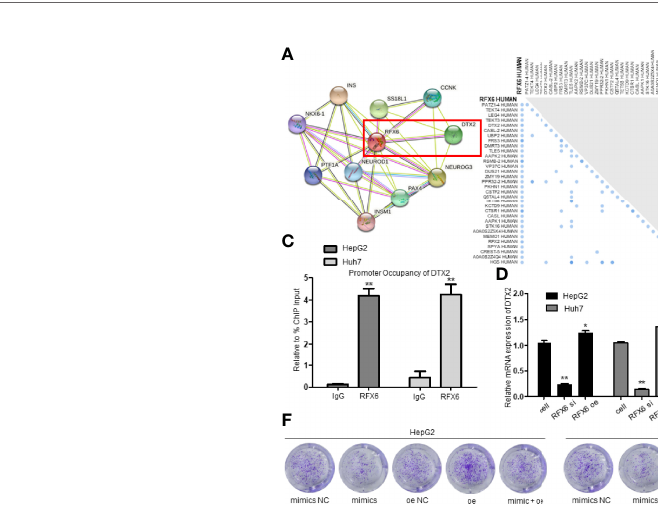
FIGURE 7 | Expression of RFX6 promotes the translation of DTX2 and participates in the Notch pathway. (A) STRING analysis predicted a network of proteins that interacted with RFX6 (left panel). UniProt analysis of probable interacting proteins of RFX6 (right panel). (B) STRING analysis of possible interacting proteins of DTX2. (C) Promoter occupancy of the DTX2 gene by RFX6 performed by ChIP-qPCR. Data were represented as mean ± standard deviation (SD), n = 3, ** p < 0.01. (D) Expression of RFX6 increased the mRNA expression of DTX2. Data were represented as mean ± standard deviation (SD), n = 3, * p < 0.05, ** p < 0.01. (E) Notch1 was con fi rmed to interact with DTX2 in HepG2 cells by co-IP assay. (F) Proliferation of liver cancer cells was retrained by the downregulation of DTX2 conducted by